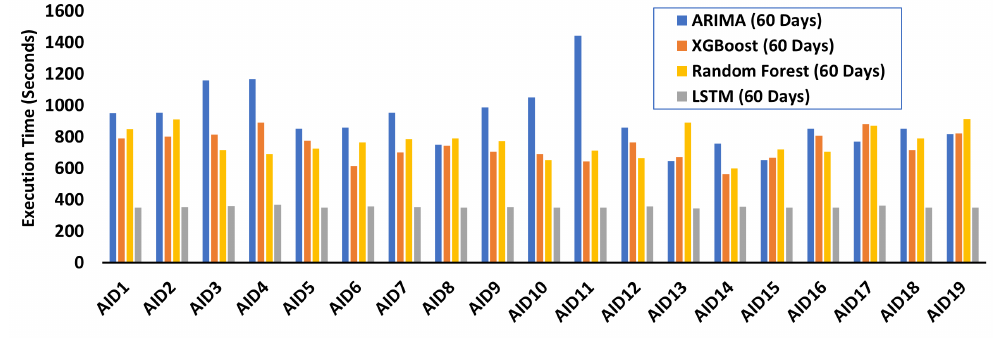
Figure A3. MAE, RMSE, and execution time from ML/DL models employing 60 days of training